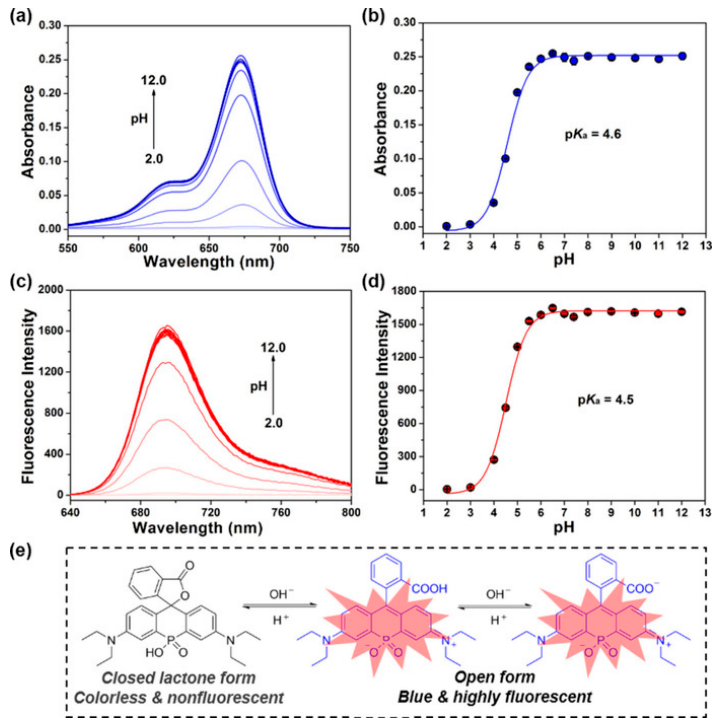
Figure 27. The pH-dependent photophysical properties of the new dye; ( a ) Absorption and ( c ) fluorescence with pH and the resulting pK a titration curves ( b , d ); ( e ) Proposed closed–open equilibrium of the spirolactone. Adapted with permission from [296].